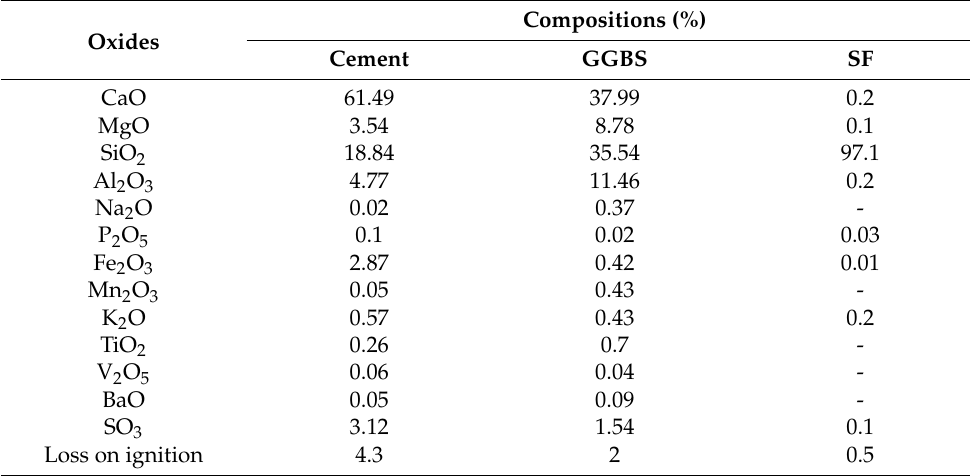
Table 1. Oxide compositions of OPC, GGBS, and